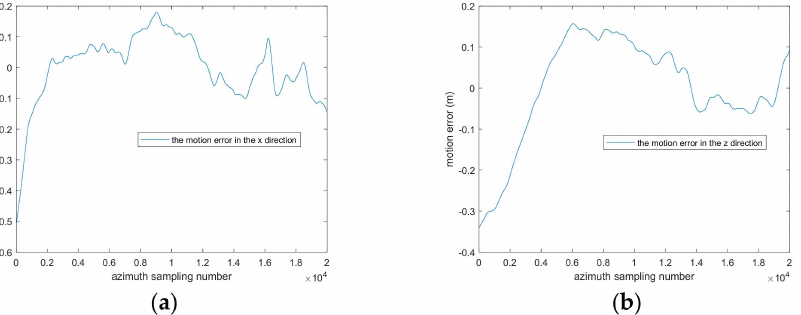
Figure 5. ( a ) Typical motion error in the x direction; ( b ) Typical motion error in the z direction.